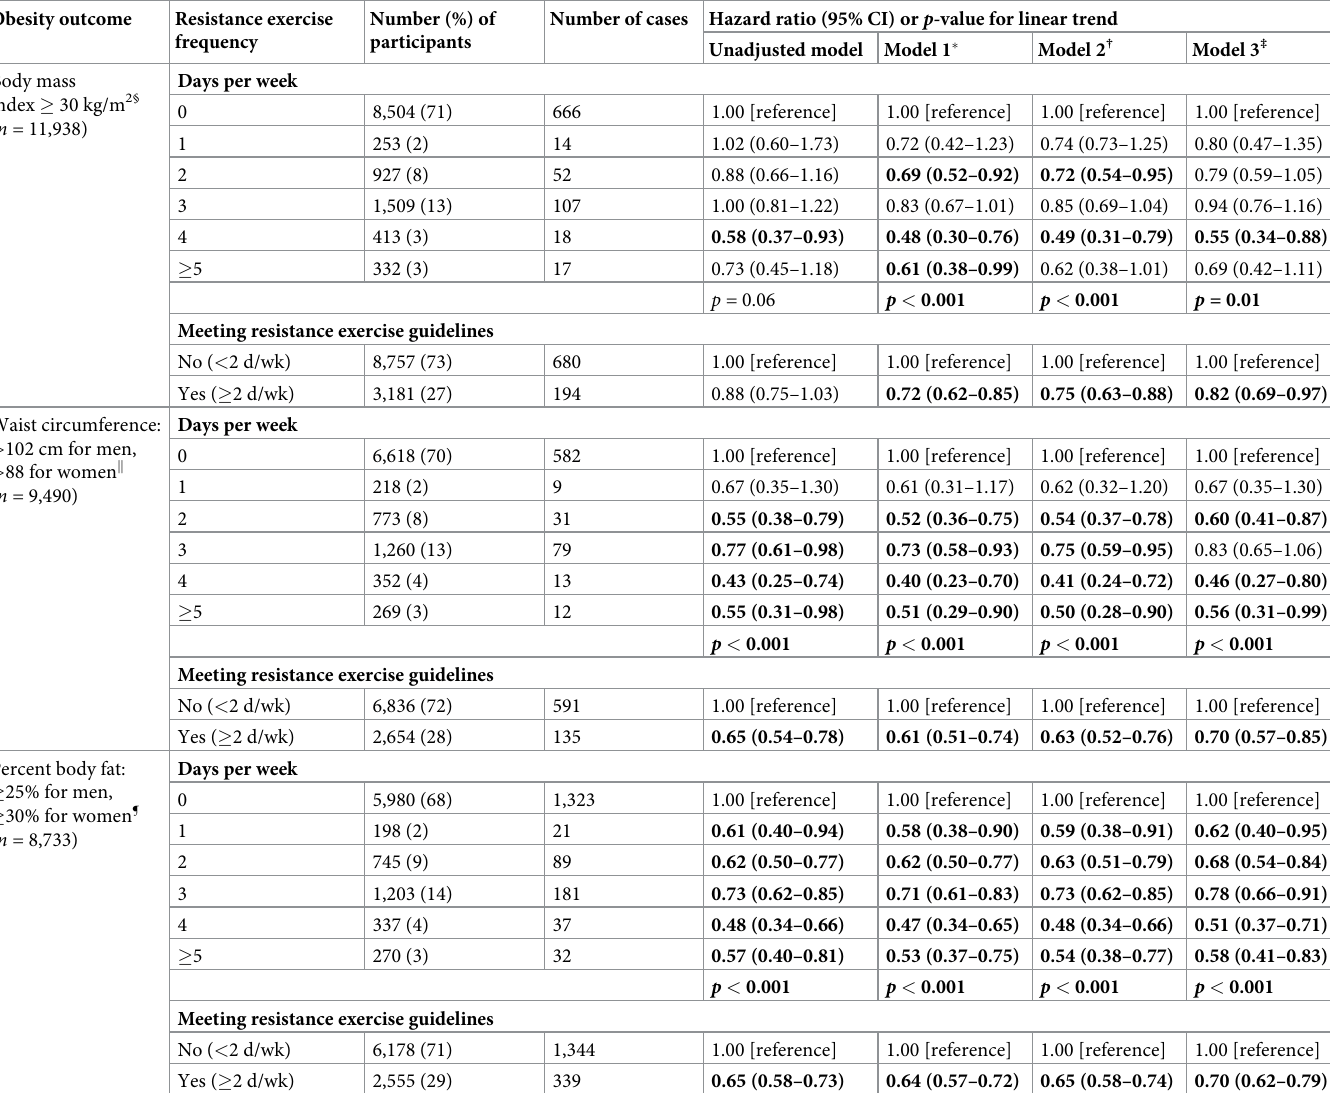
Table 3. Hazard ratios for incident obesity as defined by body mass index, waist circumference, or percent body fat by weekly frequency of resistance exercise. Obesity outcome Resistance exercise Number (%) of Number of cases Hazard ratio (95% CI) or p -value for linear frequency participants